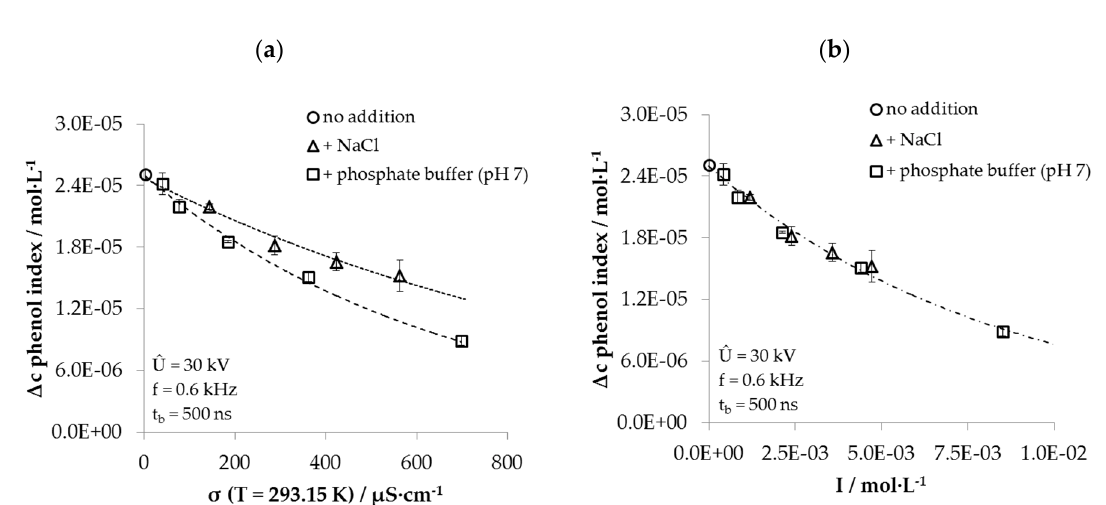
Figure 10. Decrease of phenol index concentration ( ∆ c ) ( a ) in relation to electric conductivity σ of the process water referenced to T = 293.15 K or ( b ) in relation to the ionic strength I .